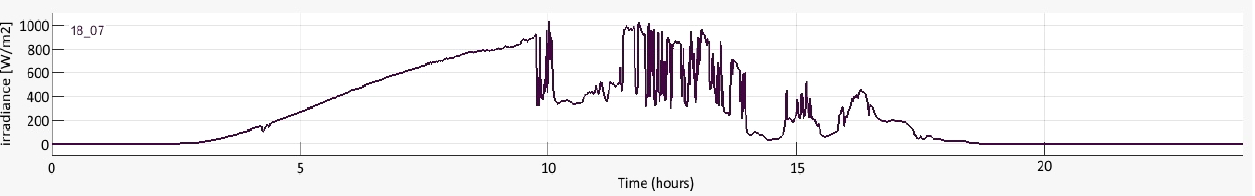
Figure 16. Daily distribution of irradiance on a sample day in July.